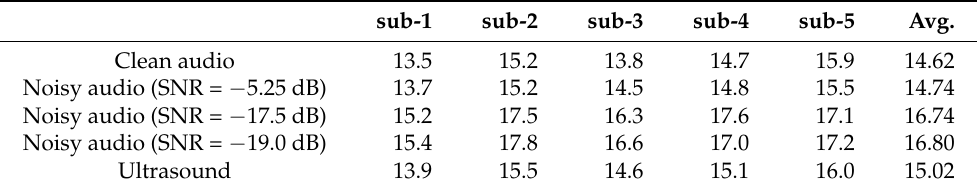
Table 6. The MAPEs of the clean audio signal, noisy audio signal, and ultrasonic signal. All results were obtained by averaging all food